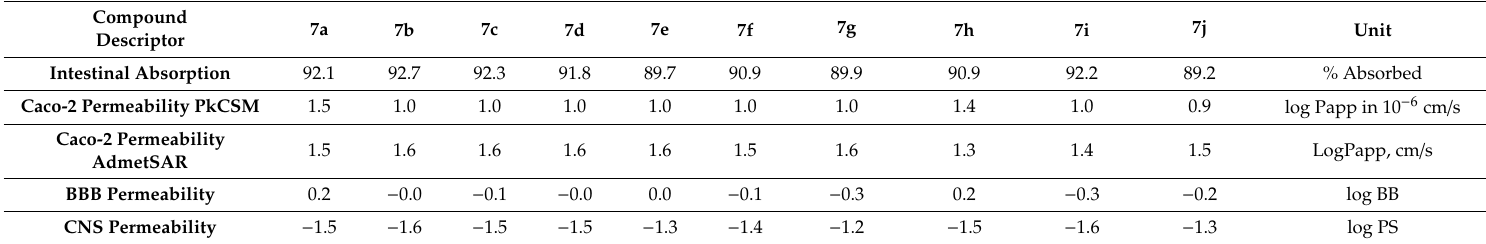
Table 2. Prediction of intestinal absorption, Caco-2, BBB and CNS permeability of compounds 7a – j